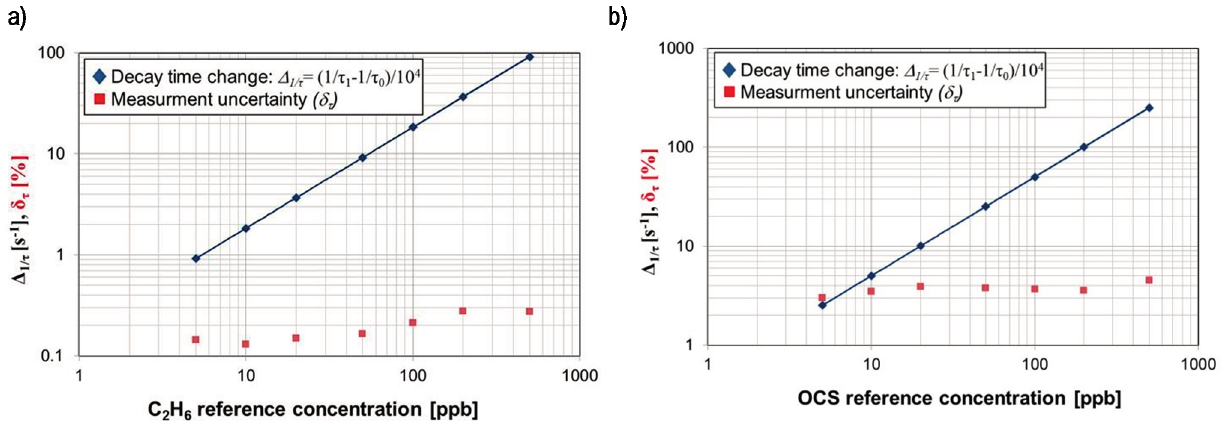
Figure 7. ( a ) Example of measurements results for ethane reference samples ( b ) and for OCS reference samples registered in the CEAS setup equipped with the PG711-DFG-SH system.